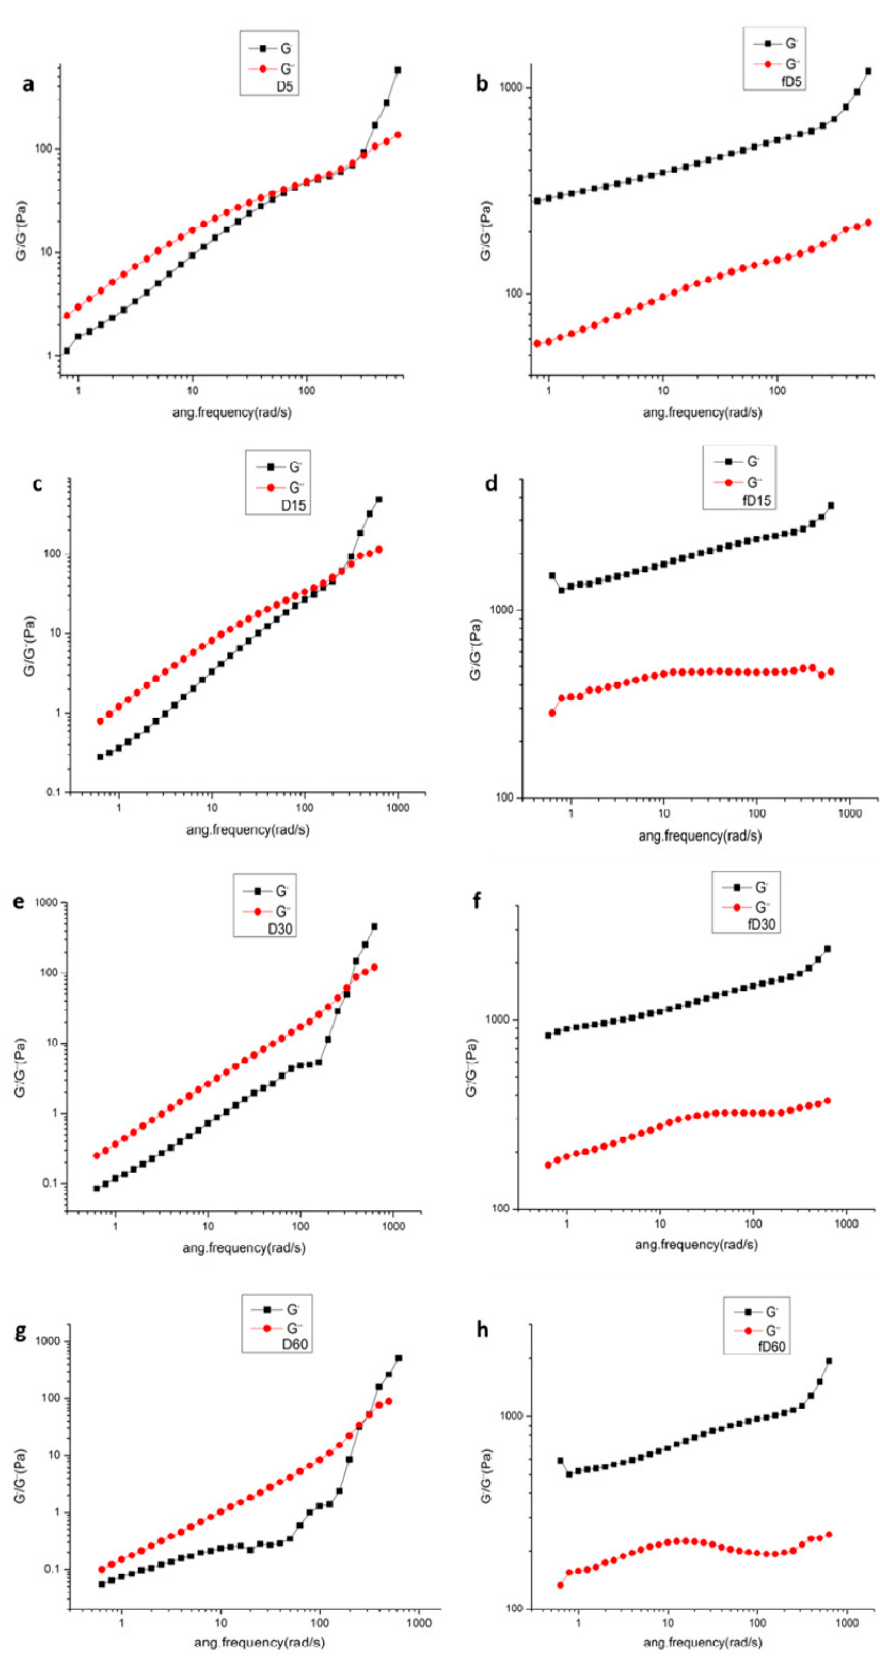
Figure 8. Frequency dependence of G ′ and G ′′ of 1% KGM sols with different sonacition time before freezing ( a , c , e , g ) and after freezing ( b , d , f , h ) dealt.